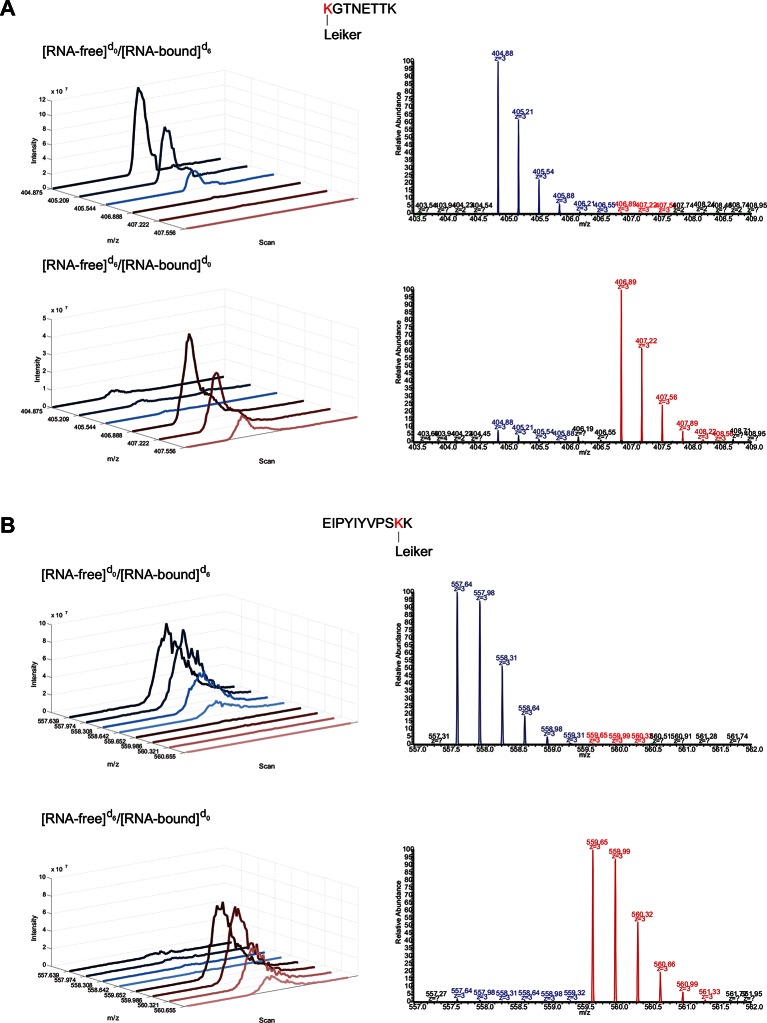
Extracted ion chromatograms (left) and representative MS1 spectra (right) of a mono-linked peptide corresponding to (A) K35 and (B) K84.